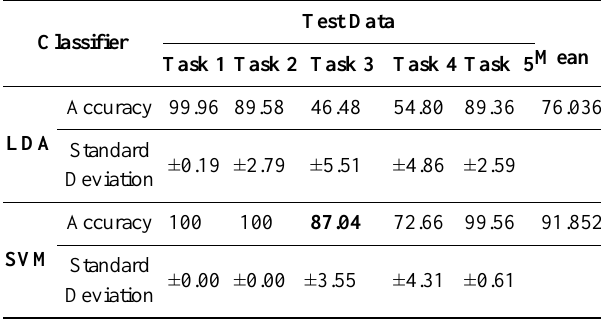
Table 4. Multi-class classification results of Subject 1 for 5